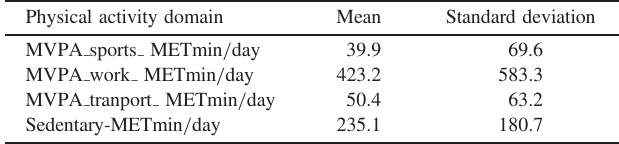
Table 3. Descriptive data of physical activity domains Physical activity domain Mean Standard deviation